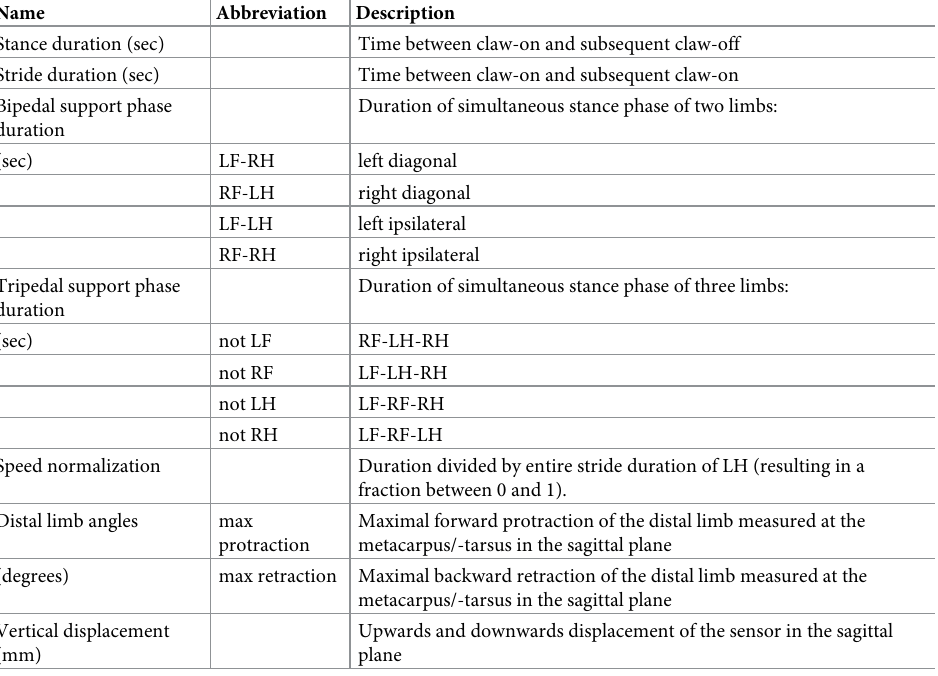
Table 1. Detailed description of the calculated parameters used in this study. Limbs are indicated by LF (left front), RF (right front), LH (left hind) and RH (right hind). These definitions are adapted from horses